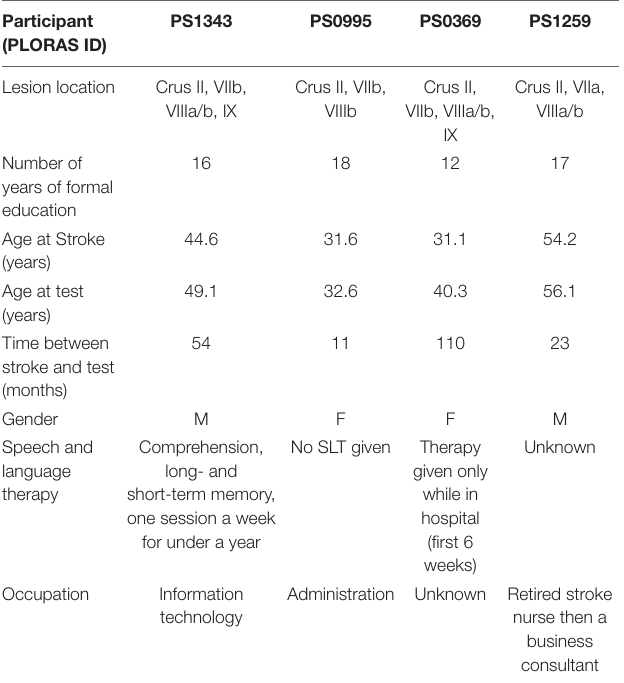
TABLE 1 | Demographic and lesion information of